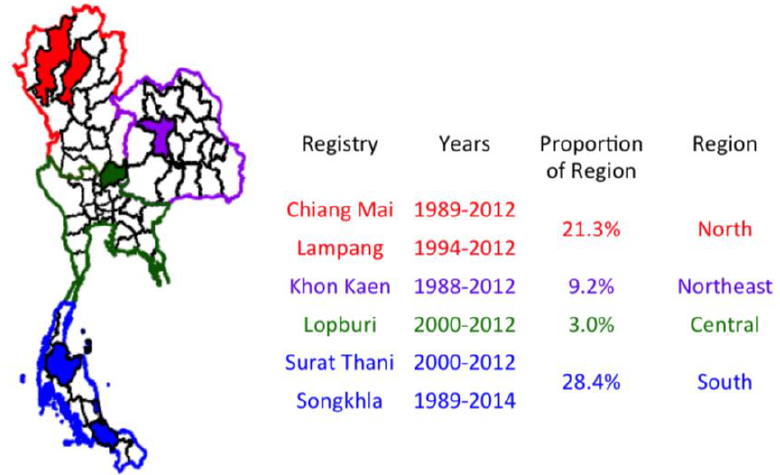
Figure 10. The Thai Cancer Information Network houses data from six high-quality cancer registries that were used to estimate subnational burdens of cancer as shown.